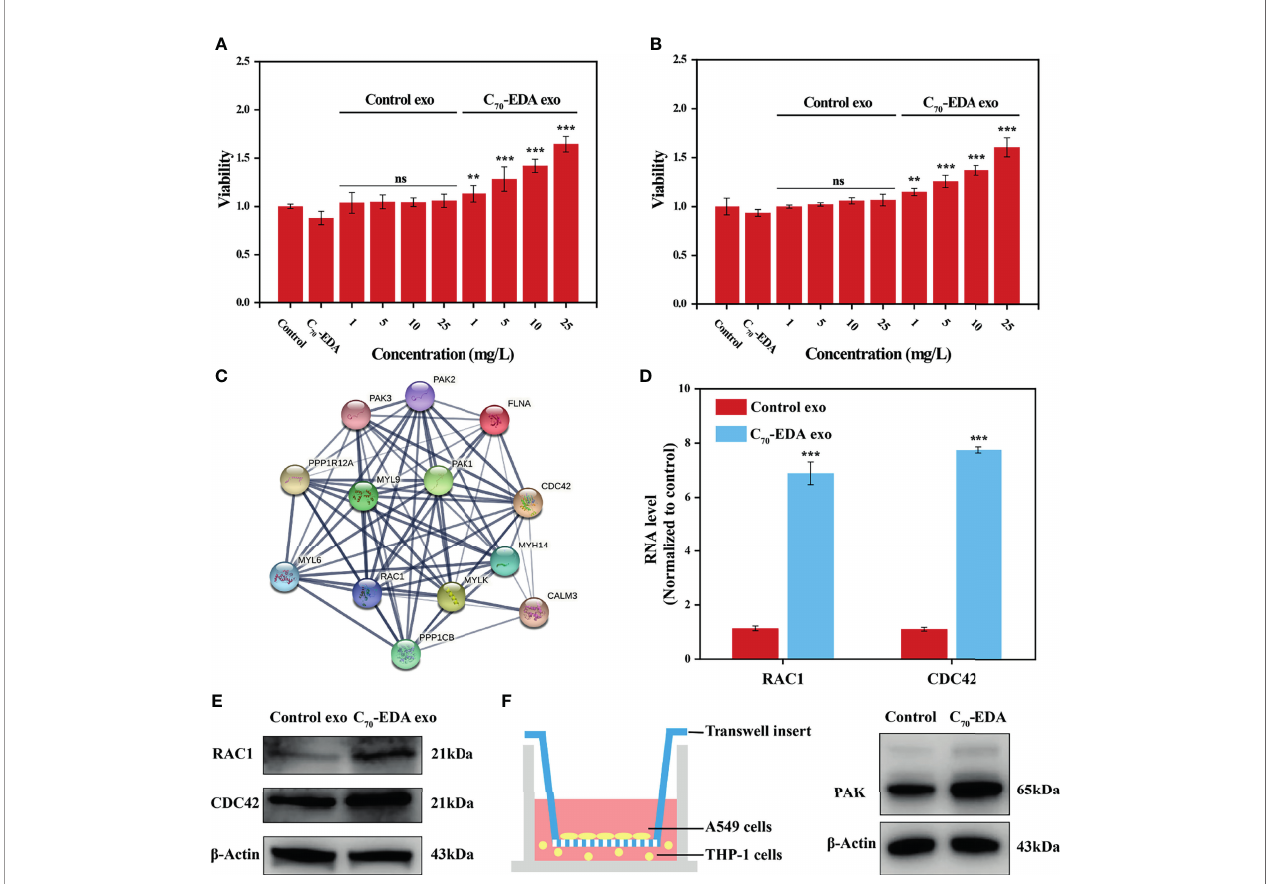
FIGURE 4 | C 70 -EDA exosomes promote tumor cell proliferation. (A, B) The viability of A549 and U87-MG cells treated with exosomes at gradient protein concentrations for 24 h (n = 4). (C) Protein interaction network of upregulated proteins involved in the Rho GTPase/PAK pathway. (D) The mRNA levels of exosomal RAC1 and CDC42 were evaluated by RT – PCR (n = 4). (E) Expression of exosomal RAC1 and CDC42 proteins derived from THP-1 cells treated with C 70 -EDA (20 m M) for 48 h. (F) Left: schematic diagram showing the Transwell coculture with A549 cells and THP-1 cells pretreated with C 70 -EDA (20 m M) for 48 h. Right: expression of PAK protein in A549 cells. The data are reported as the means ± s.d., and n represents the number of biologically independent samples. Statistical signi fi cance was calculated via Student ’ s t- test. **p < 0.01 and ***p < 0.001. ns, non-signi fi cant.